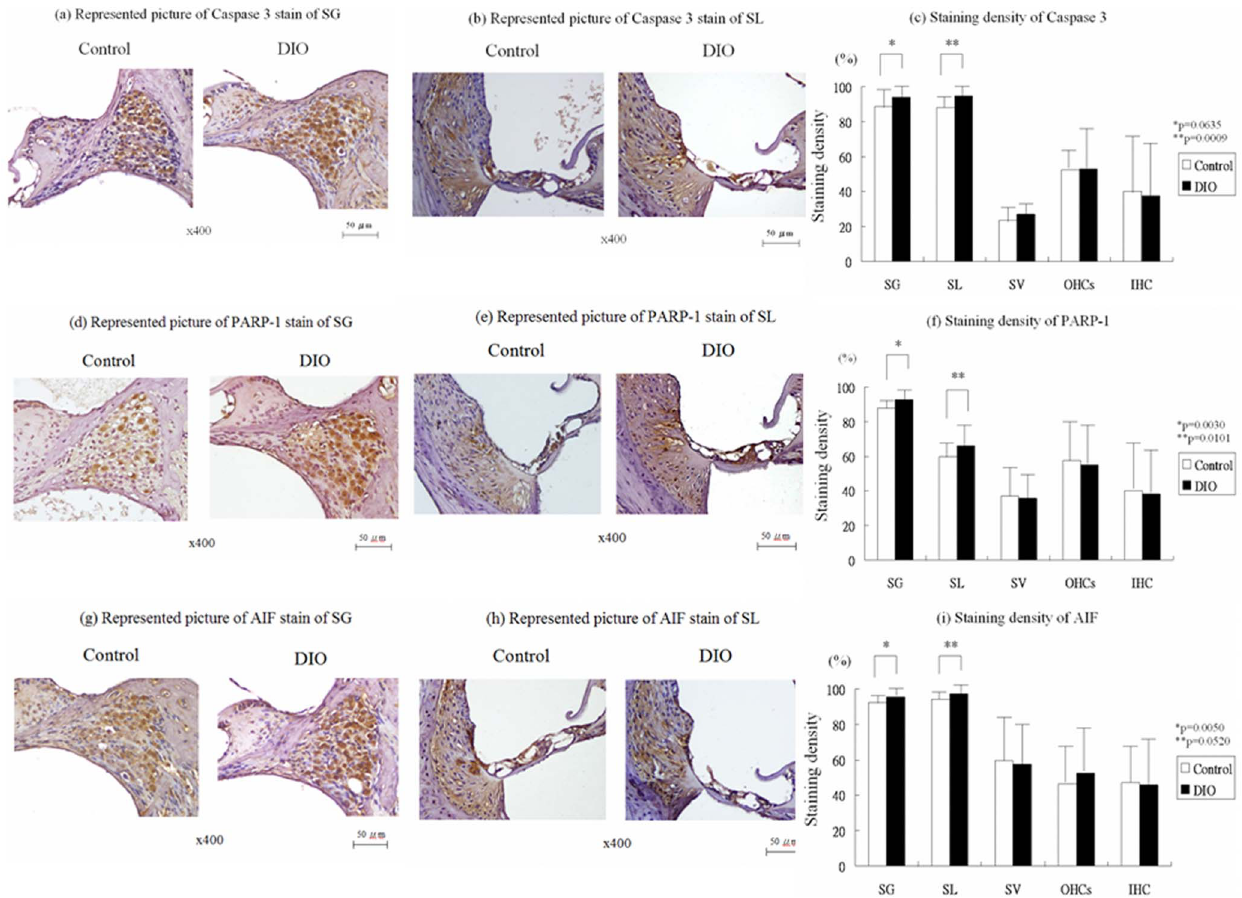
Figure 2. Immunohistochemical studies of cochlea. Representative radial section of caspase 3 staining in the cochlear basal turn (a,b). The intensity of caspase 3 stain was significantly tenser in the DIO group than in the control group in SG and SL (c). Representative radial section of poly(ADP-ribose) polymerase-1 (PARP-1) stain in the cochlear basal turn (d,e). The intensity of PARP-1 stain was significantly greater in the DIO group than in the control group in SG and SL (f). Representative radial section of apoptosis inducing factor (AIF) stain in the cochlear basal turn (g,h). The intensity of AIF stain was significantly tenser in the DIO group than in the control group in SG and SL (i).